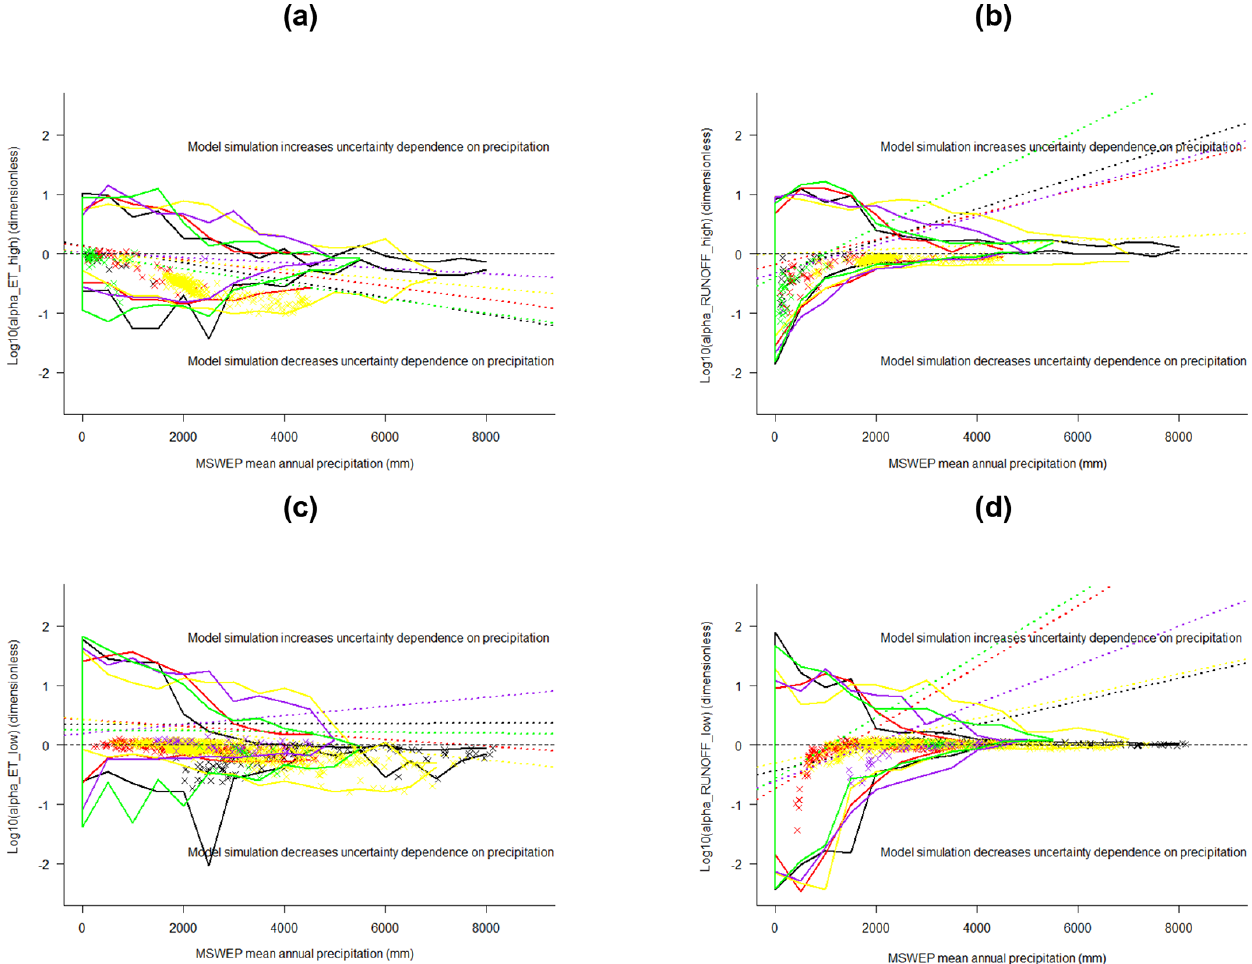
Hydrol. Earth Syst. Sci., 24, 75–92, 2020